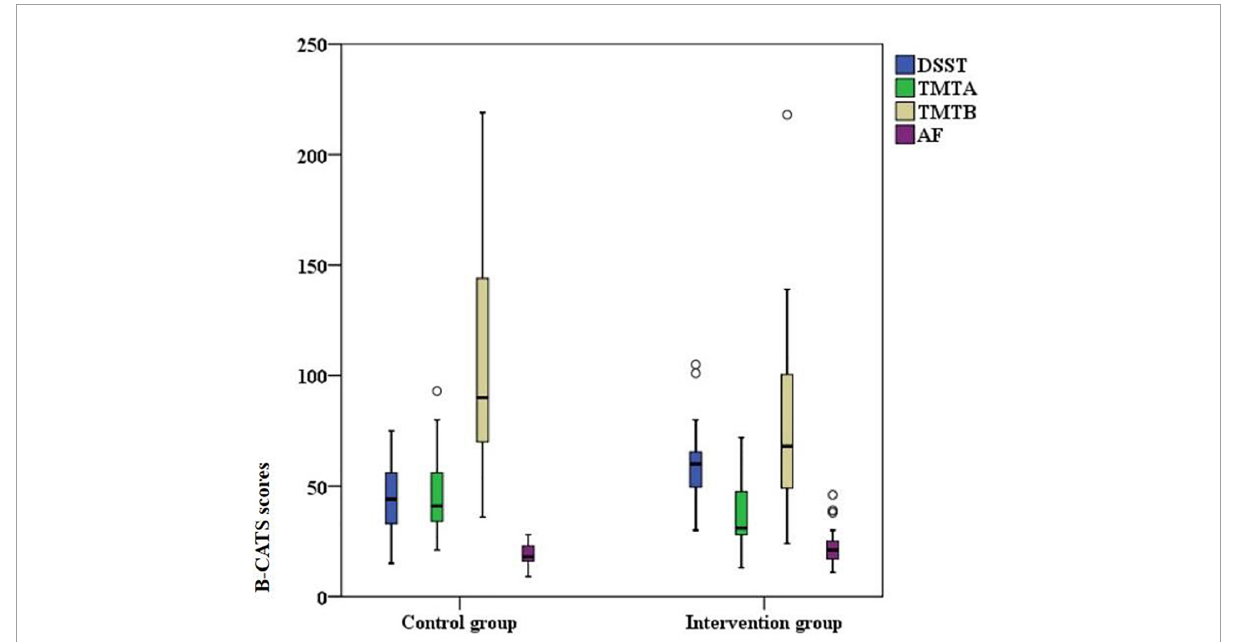
FIGURE5 Scores on the four Brief Cognitive Assessment Tool for Schizophrenia (B-CATS) tests after intervention.